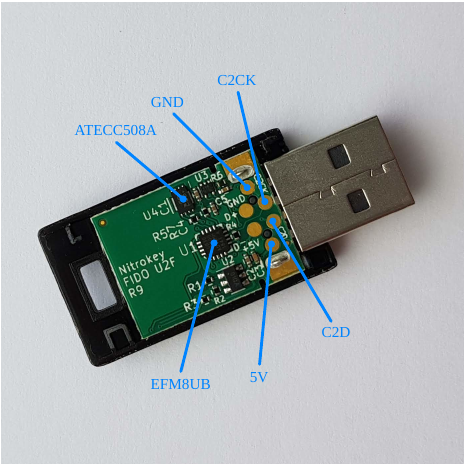
Figure 1: Nitrokey FIDO U2F with open housing. The integrated chips and accessible supply and debug pins are